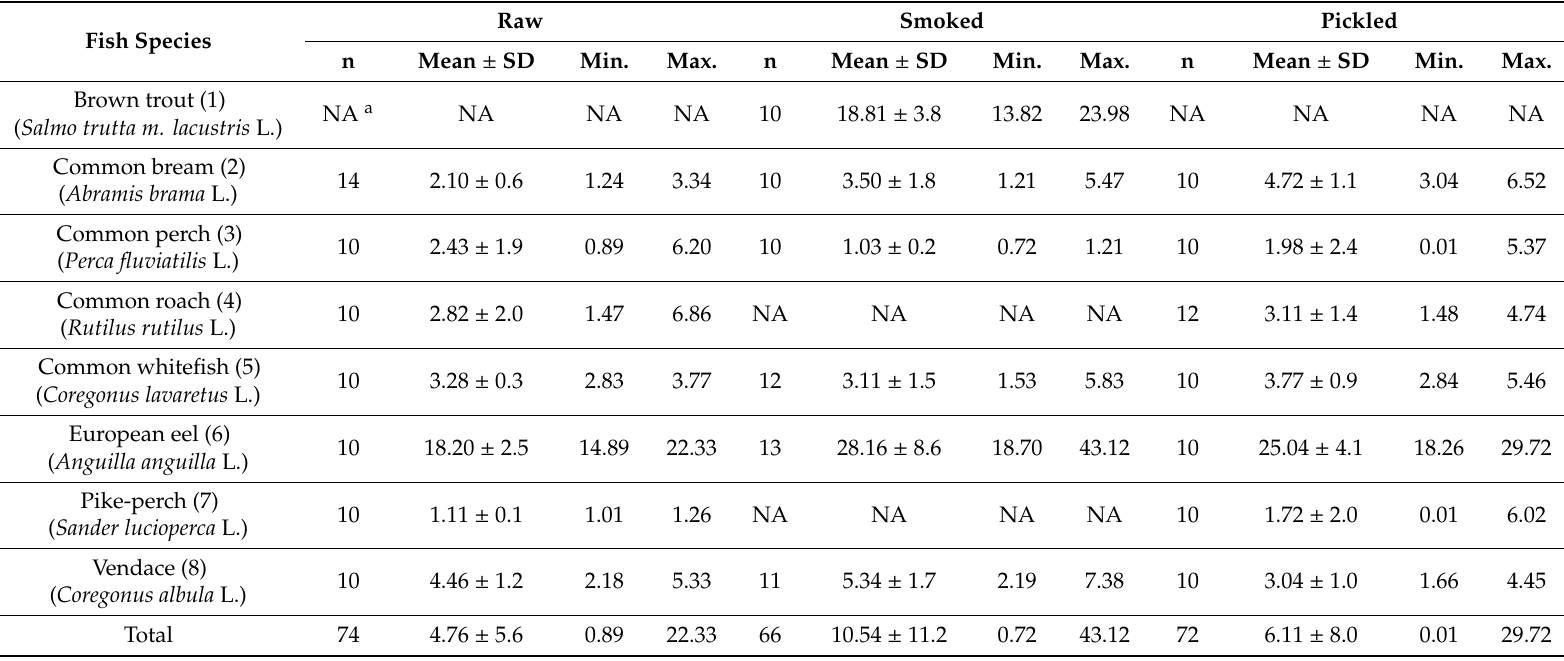
Table 2. Fat content in raw, smoked and pickled fish product samples (g / 100 g). Raw Smoked Pickled Fish Species n Mean ± SD Min. Max. n Mean ± SD Min. Max. n Mean ± SD Min.